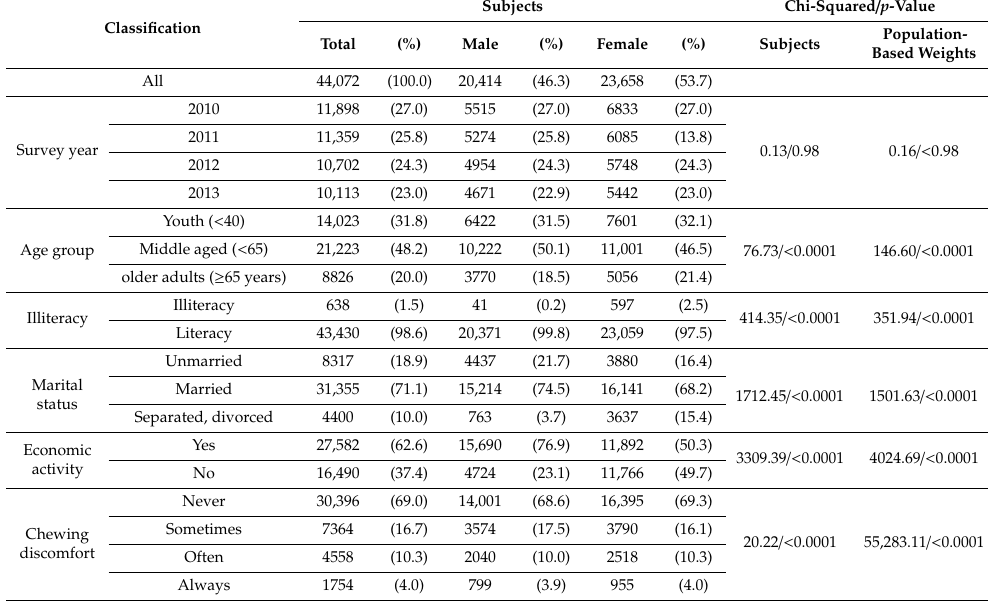
Table 1. Sociodemographic characteristics of study subjects, and sampling